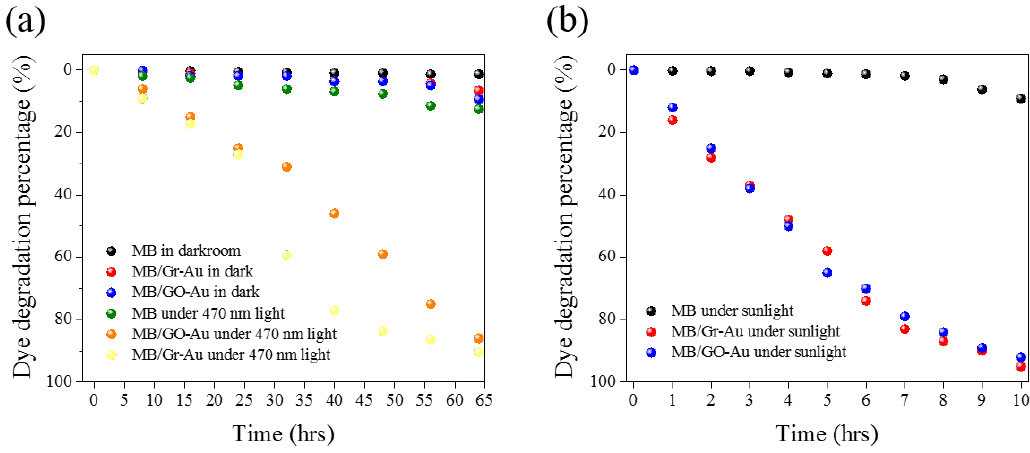
Figure 5. Photocatalytic activity of Gr / Au and GO / Au NCPs in MB solution as a function of the exposure time under ( a ) visible and ( b ) solar light.